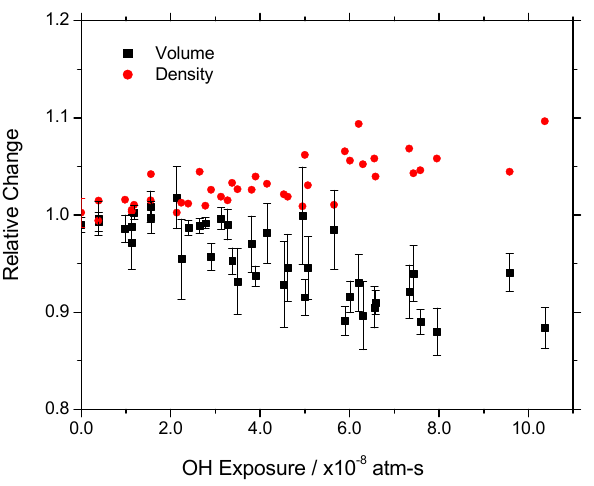
Fig. 8. Relative changes in SOA organic mass. Solid symbols are measured values and open diamonds are calculated from the data shown in Fig.